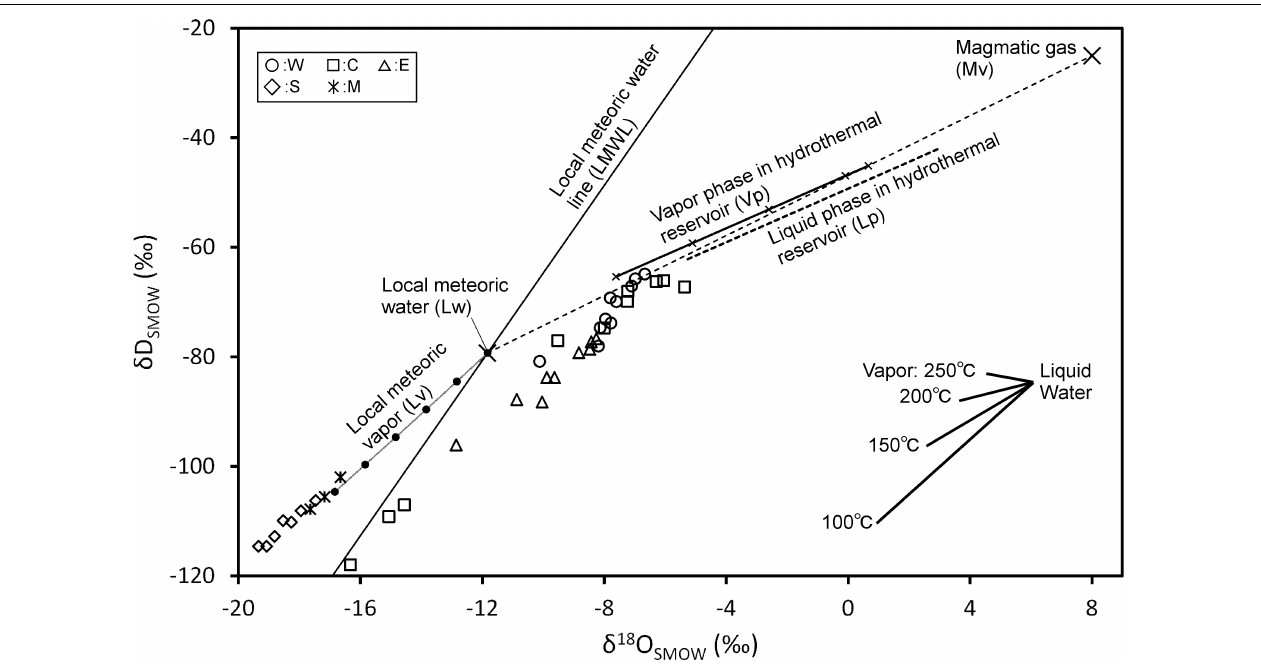
FIGURE 11 | δ D and δ 18 O of H 2 O in fumarolic gas with the modeled vapor phase in hydrothermal reservoir. The isotopic fractionation between water and vapor with various temperatures is inserted.